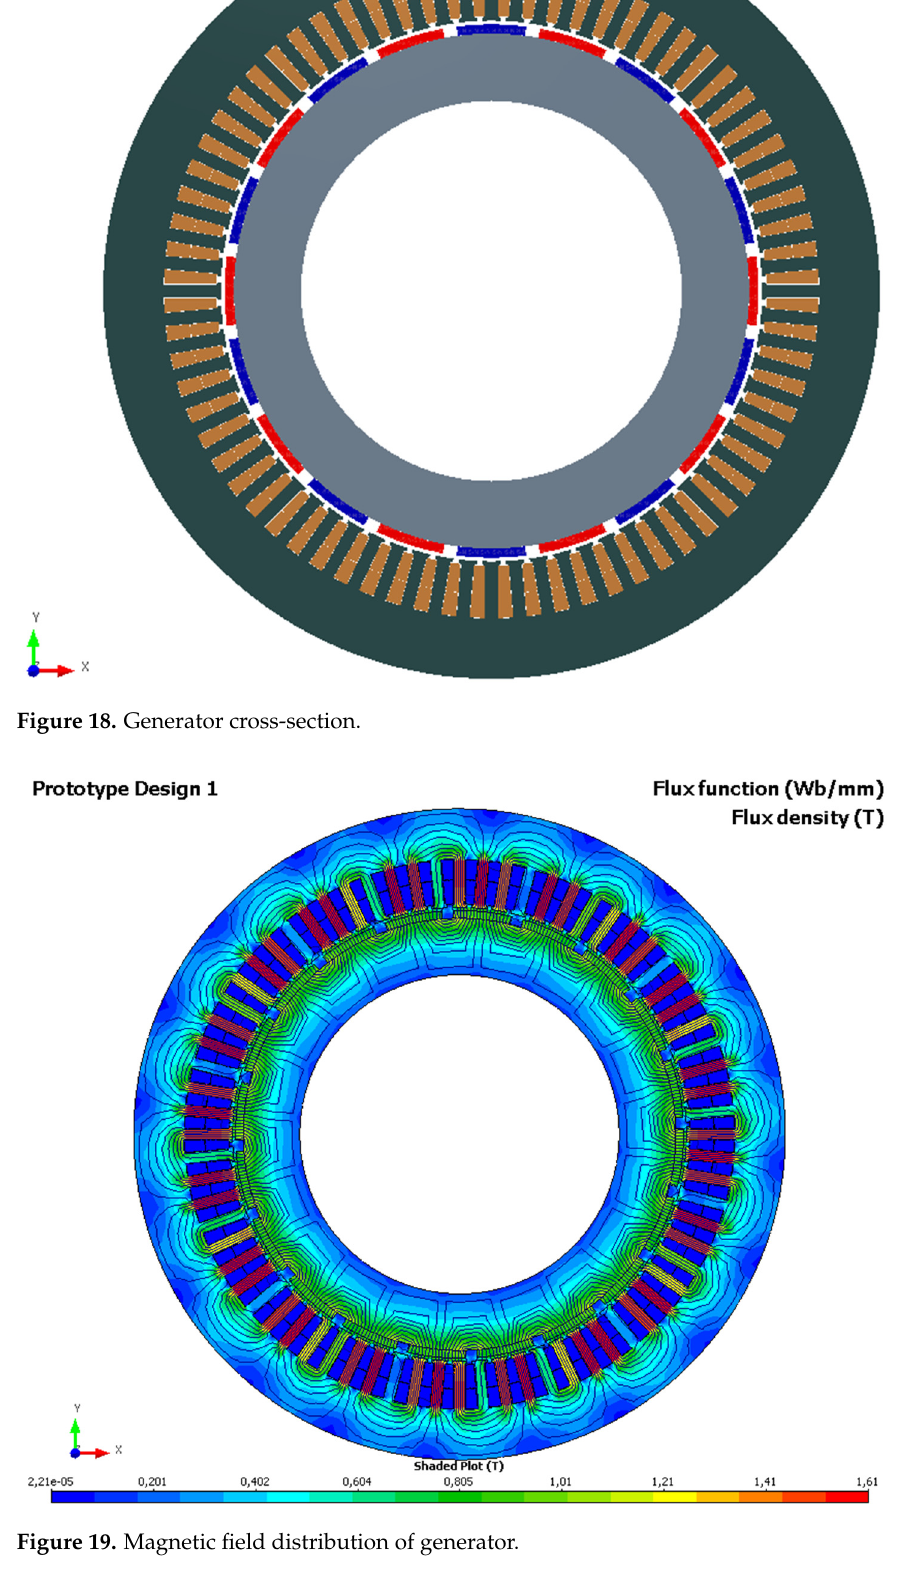
Figure 20. Generator EMF waveforms.